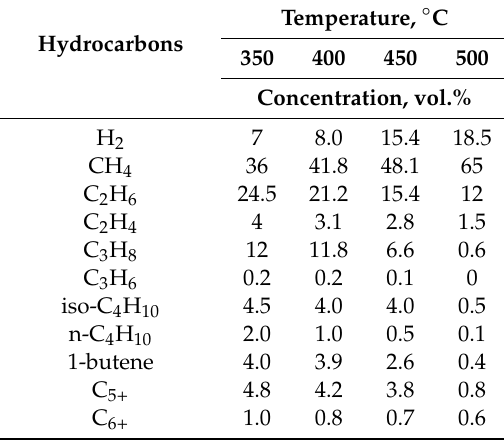
Table 5. The e ff ect of tar carbonization temperature on the composition of gaseous products (reaction time: 1